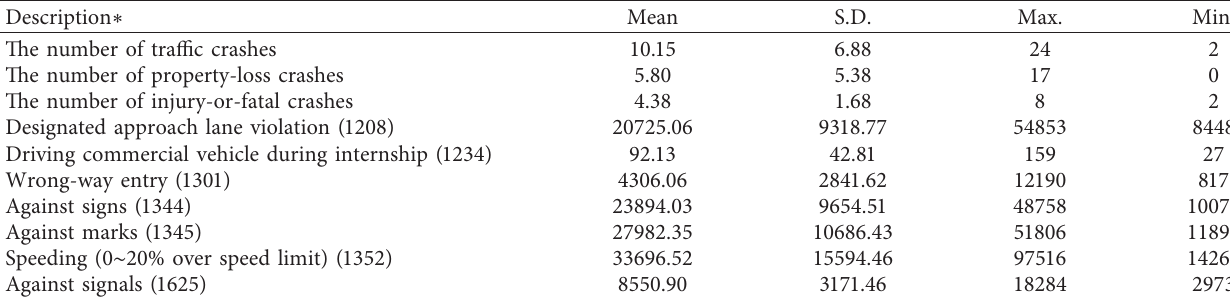
Figure 1: The installation and monitoring screen capture of the electronic police. (a) Installation. (b) Screen capture. Table 1: Descriptive statistics of